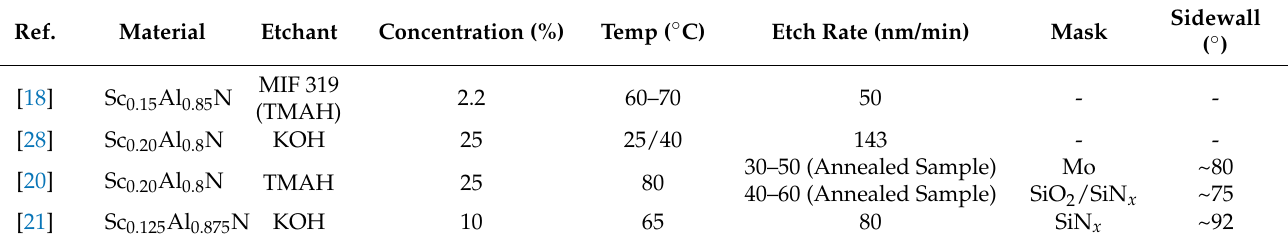
Table 2. Summary of Sc x Al 1 − x N wet etching process